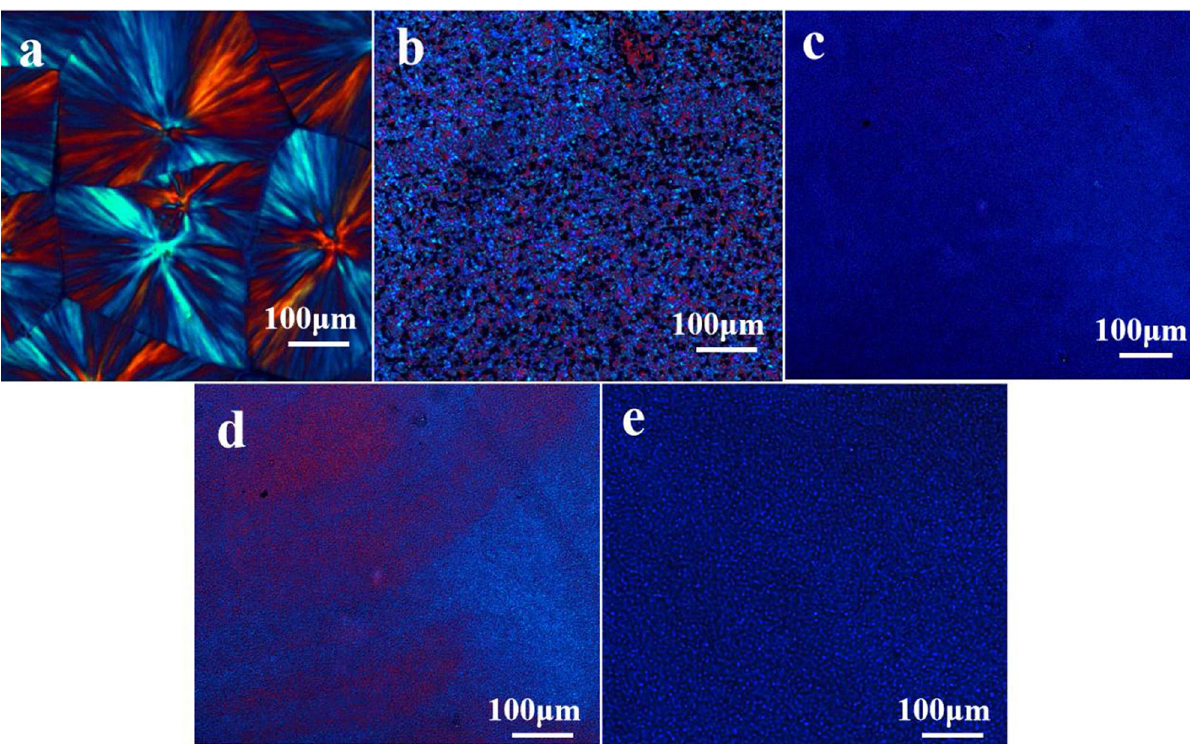
Figure 8: POM pictures of ( a ) iPP, ( b ) iPP/S0, ( c ) iPP/S1, ( d ) iPP/S2, and ( e ) iPP/S3.